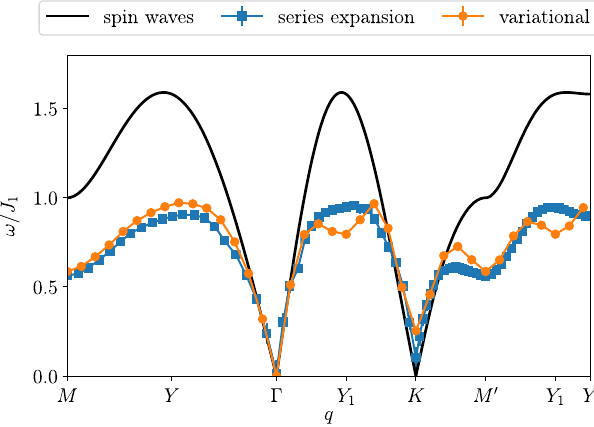
FIG. 4. Energies of the magnon branch for the nearest-neighbor Heisenberg model on the triangular lattice obtained with different methods. The path along the Brillouin zone is shown in Fig. 1. The black line corresponds to linear spin wave, the blue squares to series expansion [21], and the orange circles to our variational results (on the 30 × 30 cluster).